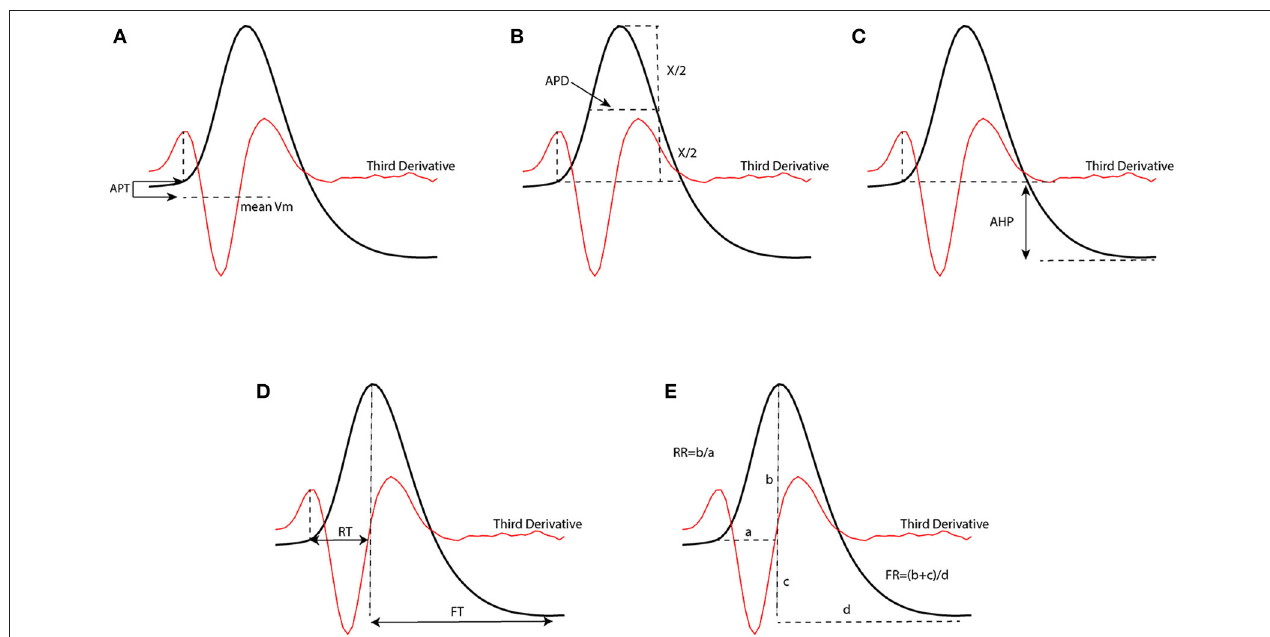
FIGURE 3 | Extracted parameters from an action potential waveform which have been used to classify neurons. [APT, action potential threshold (A) ; APD, action potential duration (B) ; AHP, After hyperpolarization (C) ; RT, rise time (D) ; FT, fall time (D) ; RR, rise rate (E) ; FR, fall rate (E) ].